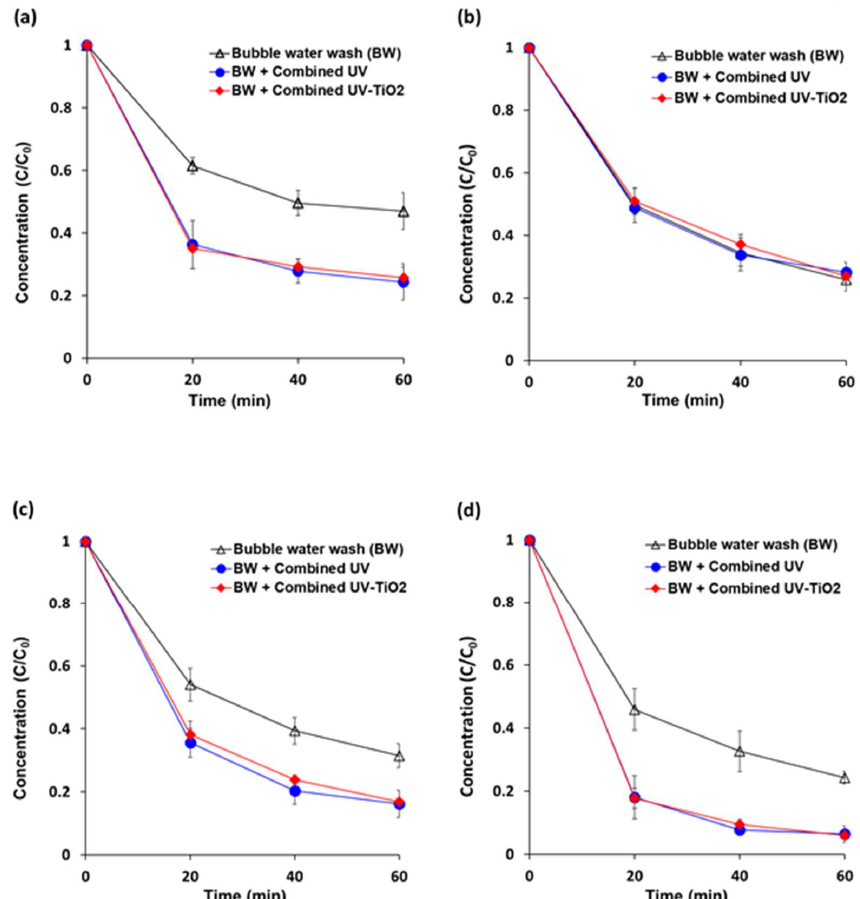
Figure 6. Removal of residual pesticide contamination from fresh cut carrots using combined UV and combined UV-TiO 2 . ( a ) pyraclostrobin; ( b ) boscalid; ( c ) fludioxonil; and, ( d ) azoxystrobin. Bubble water wash (BW) = air bubbling as a control; Combined UV = UVC and VUV; combined UV-TiO 2 = UVC-assisted TiO 2 photocatalytic; and, VUV-assisted TiO 2 photocatalytic treatment. The C 0 of pyraclostrobin, boscalid, fludioxonil, and azoxystrobin were approximately 3.5, 2.9, 3.4, and 5.7 ppm, respectively. The results represent the mean of three measurements ± standard